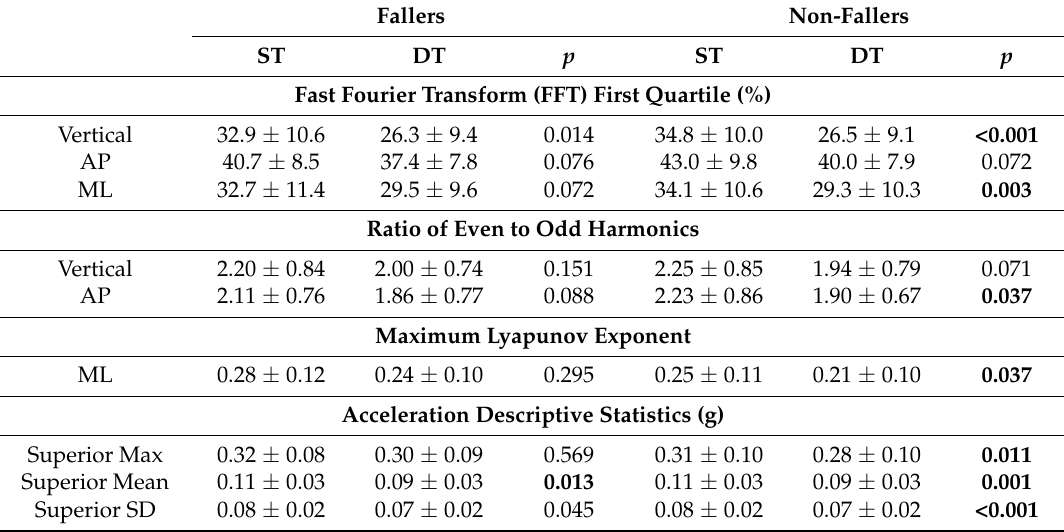
Table 3. Means and SD for posterior pelvis accelerometer variables with a significant ( p < 0.05) mixed-design ANOVA result (Supplementary Table S3). Bold p -values indicate significant differences between ST and DT conditions after correction for multiple